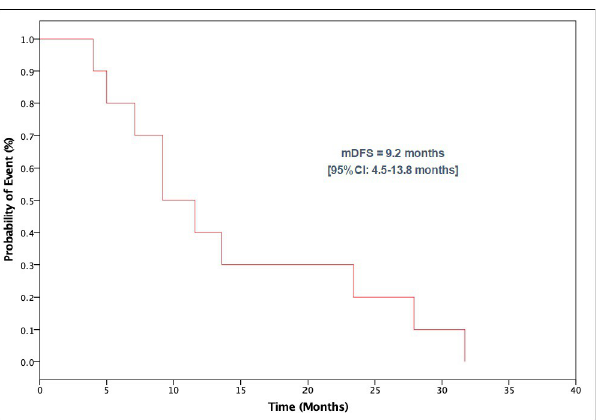
Fig 1. Kaplan Meier curve of disease-free survival for non-metastatic patients. Abbreviations: mDFS, median disease-free survival.